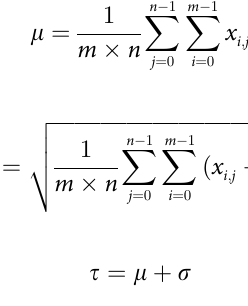
cross-section of a softwood species were first stored in a two-dimensional matrix defined as f (x , y) , converted into a grayscale image, and then changed into a black-and-white binary image. Every pixel point of the color image was calculated by Eq 1 below. The gray value of R, G, B ranges from 0 to 255, and values of all these pixel points lay between 0 to 255 calculated by Eq 1. Image’s dark pixel points represent the tracheid wall thickness, due to tracheid wall is dark but tracheid lumen is light. Gray ¼ R � 0 : 299 þ G � 0 : 587 þ B � 0 : 114 ð 1 Þ For segmenting an image, setting up the threshold was simple, efficient, and fast [24]. At Step 5, thresholds were calculated by the program designed by the authors. Threshold values may be changed with different grayscale images. For getting the threshold τ , the program cal- culated the average value μ and standard deviation σ of all pixel points. These parameters μ , σ , and τ were calculated by Eqs 2, 3, and 4, respectively.